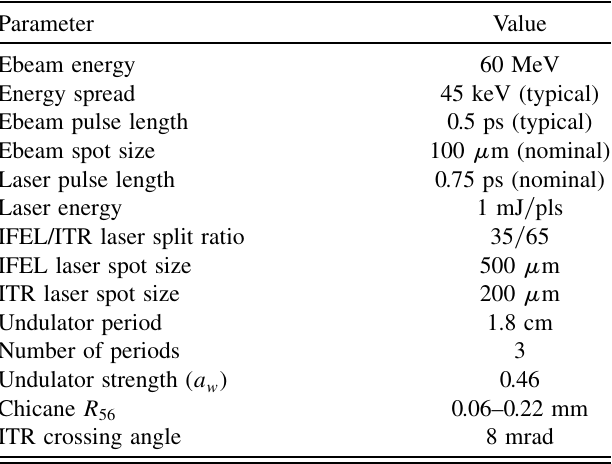
TABLE I. Experimental parameters for the net acceleration experiment. All width values are